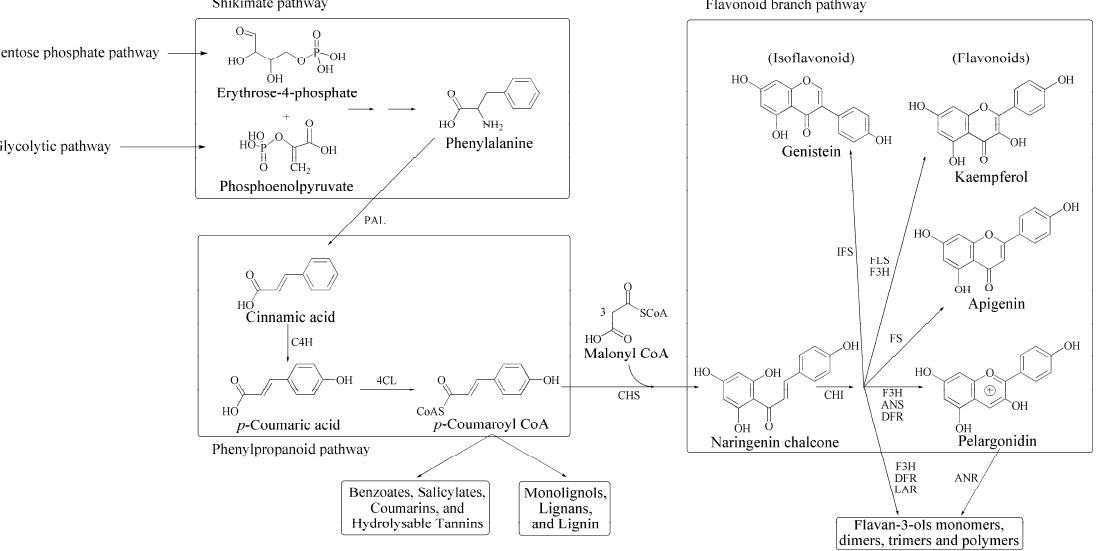
Figure 1. General biosynthetic pathway of phenylpropanoid and flavonoid structures. PAL, General biosynthetic pathway of phenylpropanoid and flavonoid